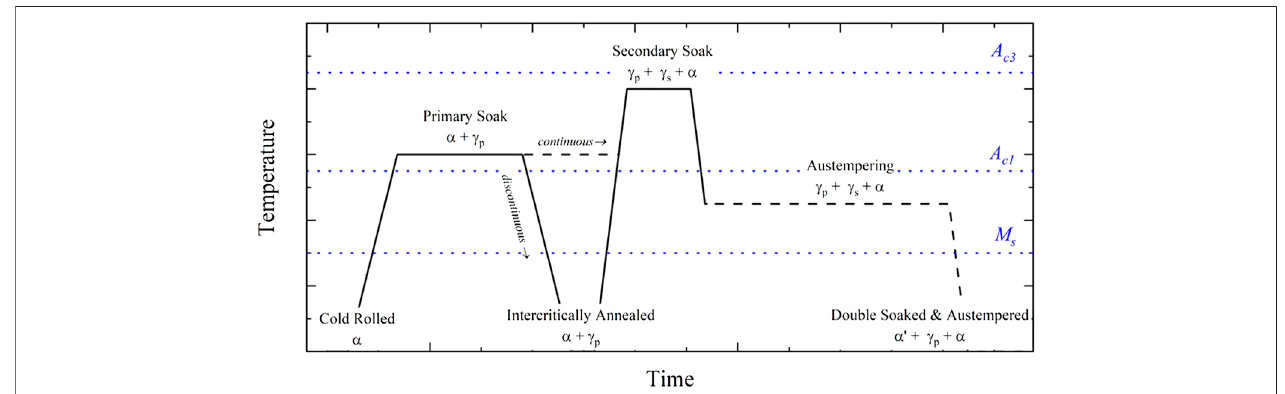
FIGURE 2 | Schematic of the double soaking plus austempering (DS-A) heat treatment. Expected changes in microstructure are indicated: ferrite ( α ), primary austenite ( c P ), secondary austenite ( c s ), bainitic ferrite ( α b ) and martensite ( α ′